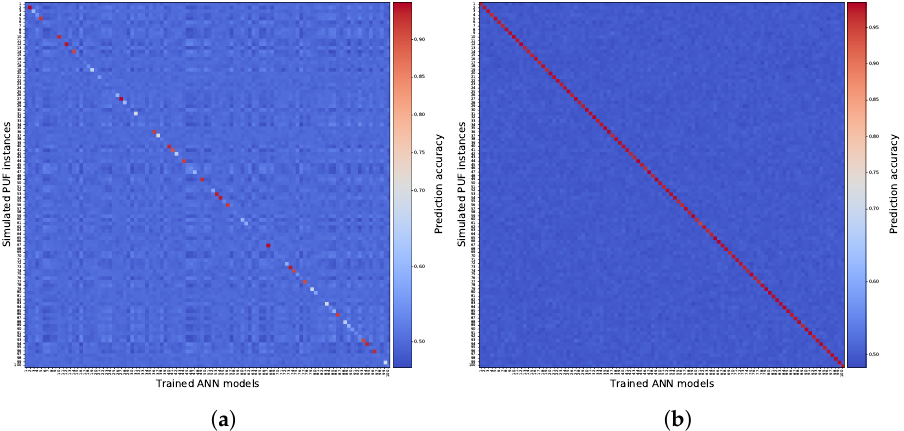
Figure 9. Similarity matrices showing the similarity between 100 trained models and 100 instances of a 128-stage 2-XOR Arbiter PUF. ( a ) css tr = 3000; ( b ) css tr =